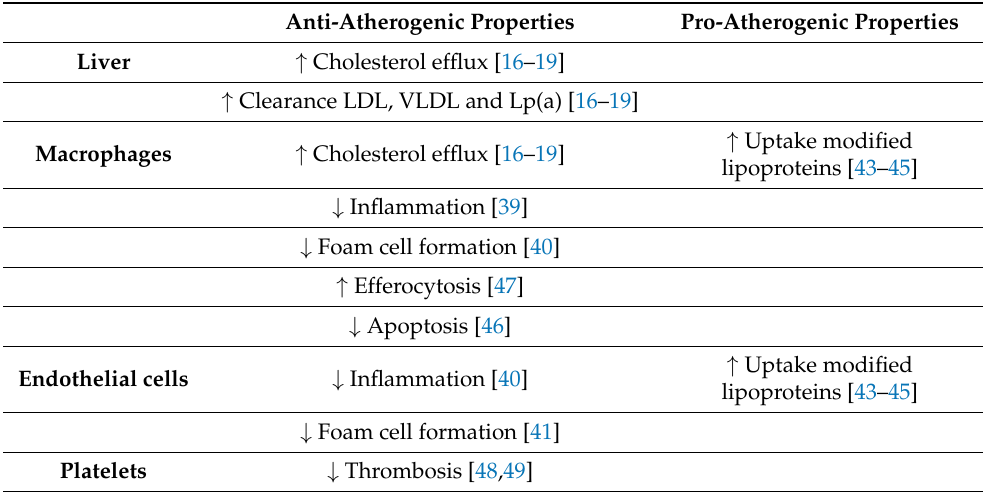
Figure 1. The role of SR-B1 in progression of atherosclerosis. LDL, low-density lipoprotein; Lp(a), lipoprotein (a); VLDL, very low-density lipoprotein; ↑ increase; ↓ decrease.